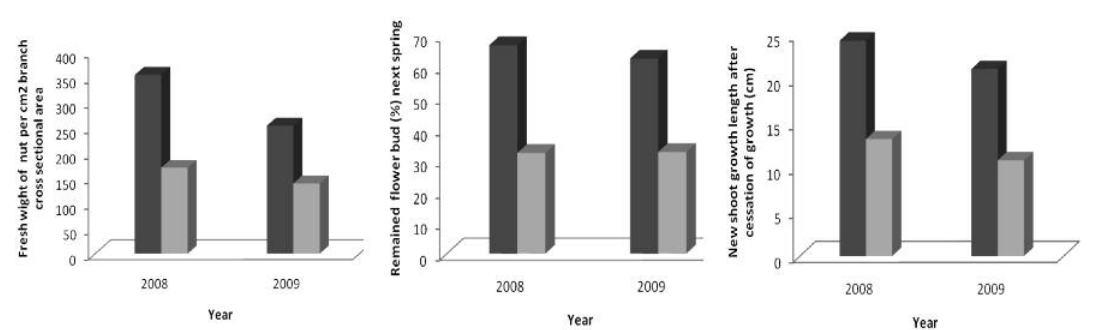
Figure3. Fresh weight of nut per cm 2 branch cross sectional area, remained flower bud (%) next spring and new shoots growth length after cessation of growth (cm). Black and gray columns in graph stand to sprayed and control trees